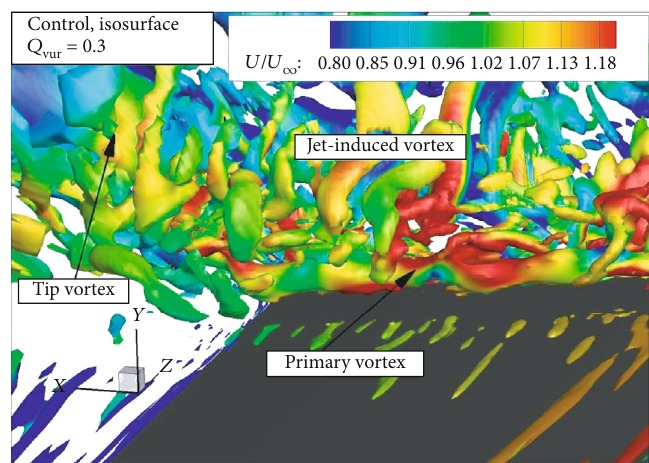
Figure 23: The structure of the wingtip vortex near the trailing edge under normal